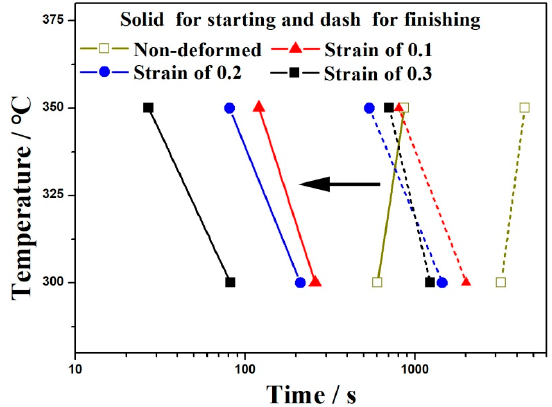
Figure 9. Effects of ausforming at 300 and 350 °C on kinetics of subsequent isothermal bainitic transformation.